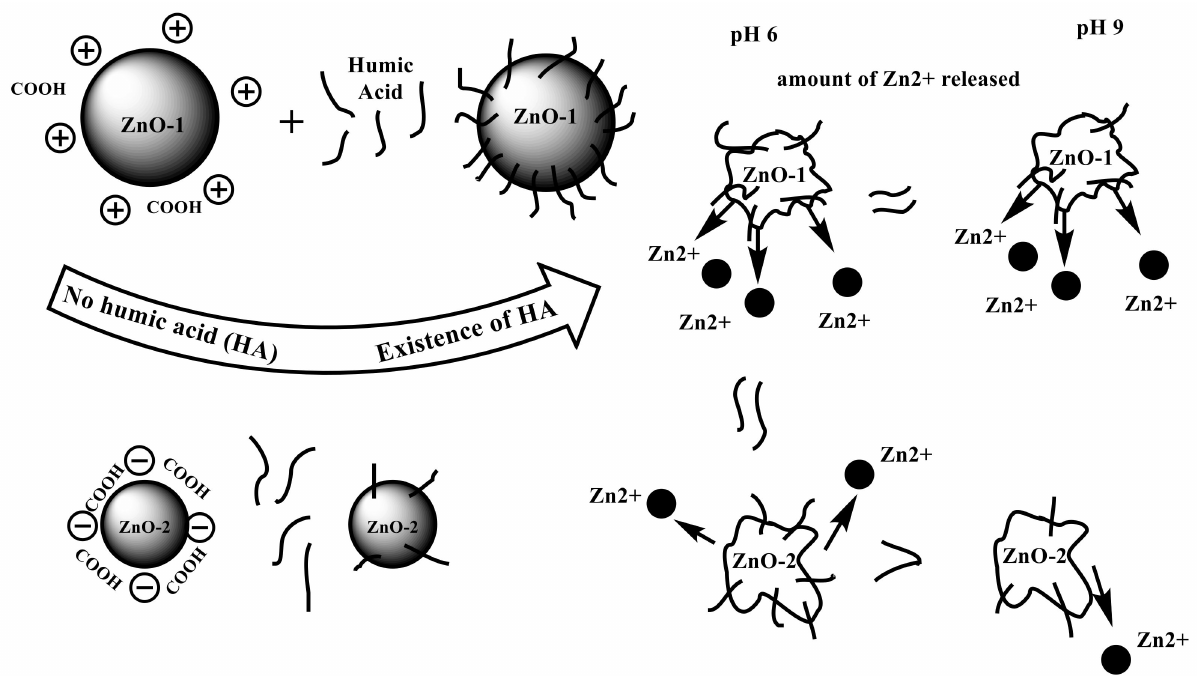
Figure 2. Effects of humic acid and pH on the release of Zn 2+ in the marine